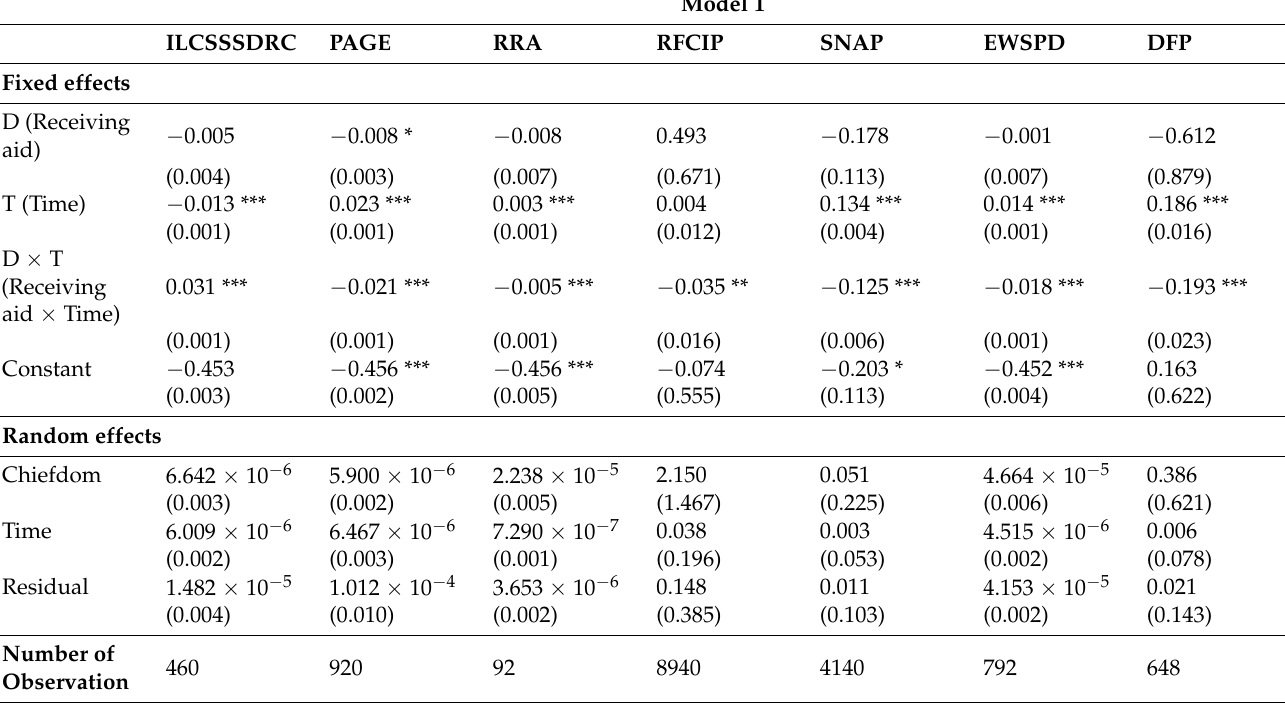
Table 3. Causal effect of agricultural aid on sum forest NDVI by types of agricultural aid. Model